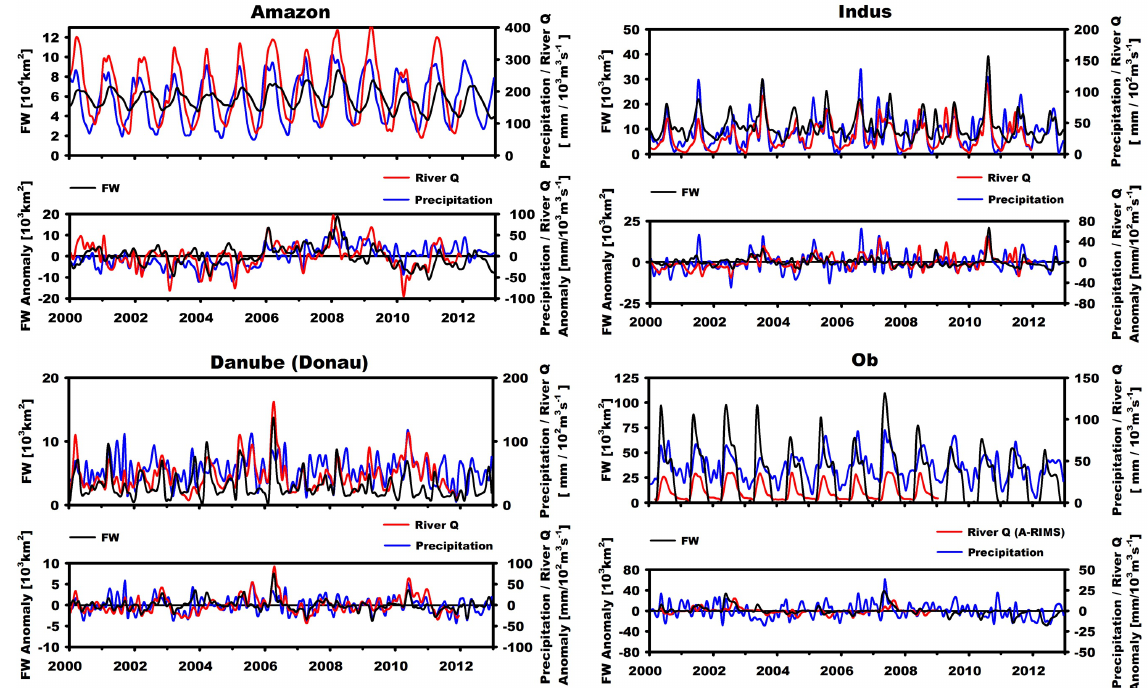
Figure 11. Monthly mean river discharge from WBM simulations, basin-averaged total monthly MERRA precipitation and corresponding basin-wide monthly mean total FW extent for the Amazon, Indus, Danube and Ob river basins over the 13 year, combined v1-QSCAT (2000–2008) and v2-ASCAT (2009–2012) FW record along with corresponding deseasonalized monthly anomalies. River Q is not available for 2012, and is limited from 2000–2008 in the Ob